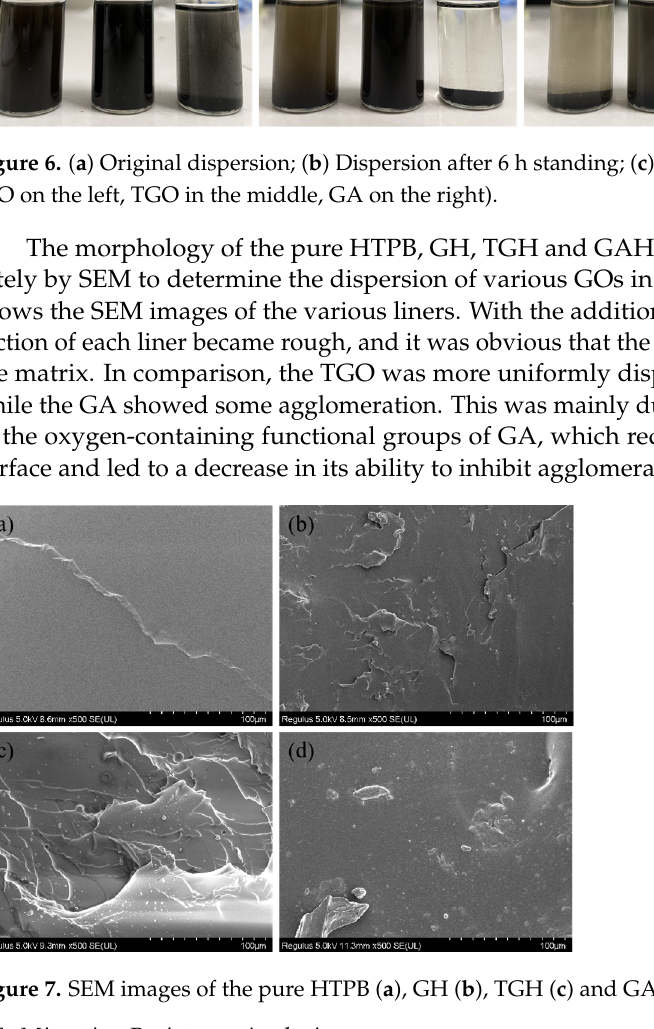
8 of 15 Figure 5. SEM images of GO ( a , b ), TGO ( c , d ) and GA ( e , f ) . After GO was modified by ODA, a large amount of oxygen-containing functional groups were consumed by the reaction. Therefore, compared with GO, GA had a flatter